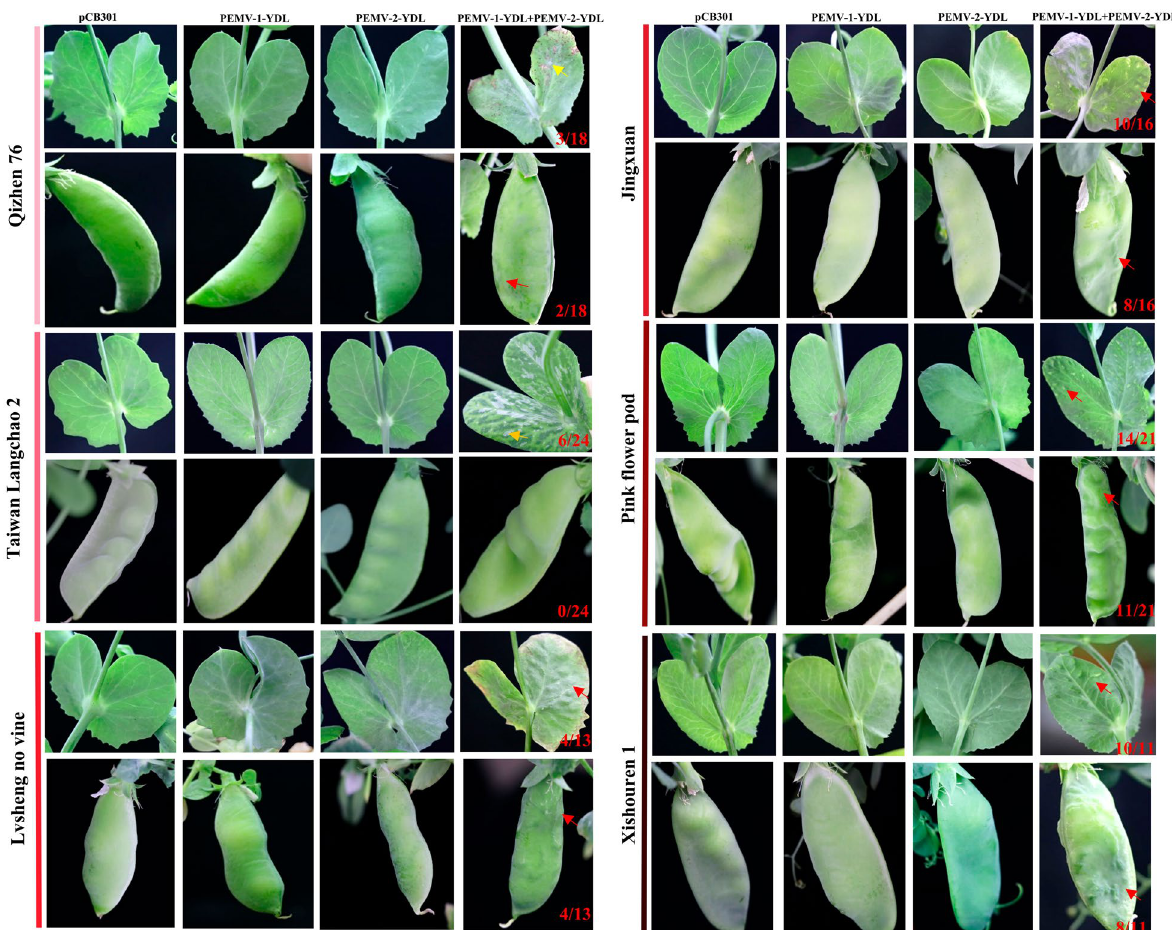
Fig. 5 Symptoms in the systemic leaves of different cultivars of pea plants inoculated either alone or in various combinations by PEMV-1-YDL and/or PEMV-2-YDL using agro-infiltration. Red, orange, and yellow arrows indicate enations, chlorosis, and necrotic spots in the systemically infected leaves and pods. Images were taken at 21 days post-infection (dpi) for pea plants and 33 dpi for pea pods. The plants were inoculated with Agrobacteria that harbor the pCB301 vector as a